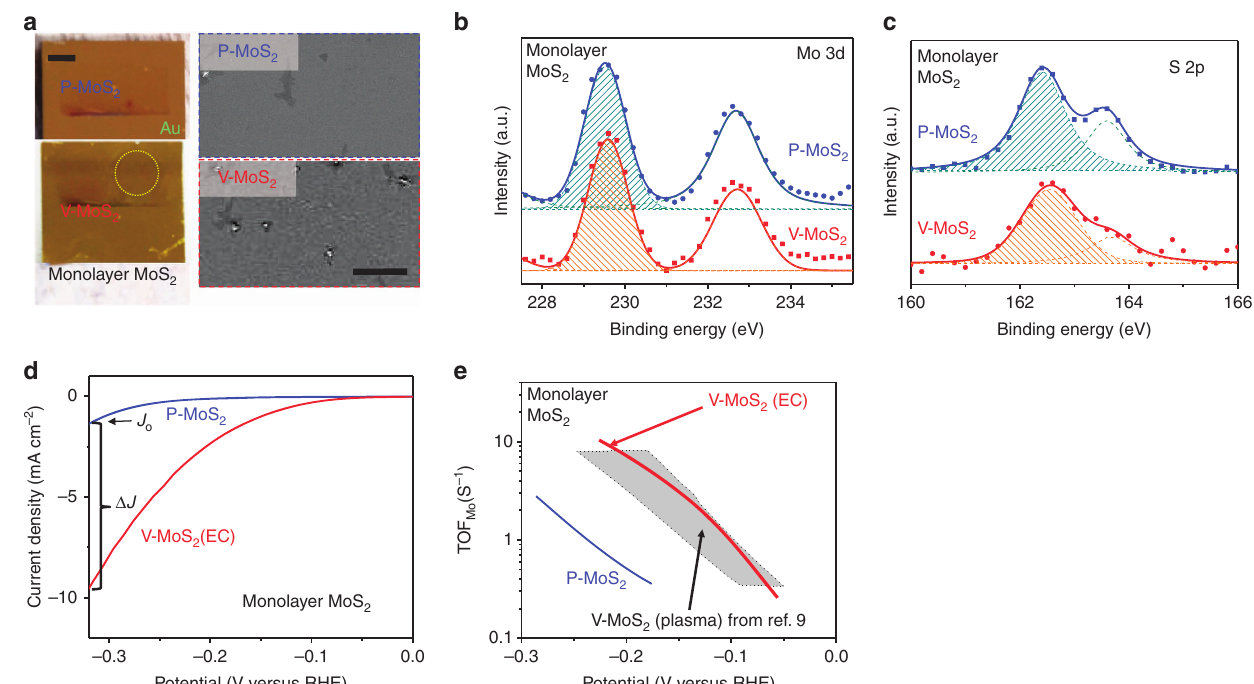
Figure 3 | Characterizations and catalytic activity of monolayer MoS 2 . ( a ) Optical (left panel; scale bar, 2mm) and SEM images (right panel; scale bar, 20 m m) of monolayer MoS 2 film before (P-MoS 2 , upper panel) and after (V-MoS 2 , lower panel) desulfurization. ( b ) XPS Mo 3d and ( c ) S 2p peaks of pristine MoS 2 (P-MoS 2 , upper curves) and MoS 2 with S-vacancies (V-MoS 2 , lower curves). The filled symbols are measured data, and the solid lines are the parametric fits. The dashed lines with enclosed shaded areas label the major peak used to characterize the S:Mo atomic ratio. ( d ) LSV of monolayer MoS 2 before and after desulfurization, respectively. The current density increment is defined as D J / J 0 , where J 0 is the current density at (cid:2) 0.32V versus RHE before desulfurization. ( e ) TOF per surface Mo atom (TOF Mo ) as a function of applied potential for MoS 2 monolayers before and after desulfurization. The results from previous work where Ar plasma was employed for desulfurization are also shown for comparison (shaded area). All the current densities are defined based on the total electrode surface